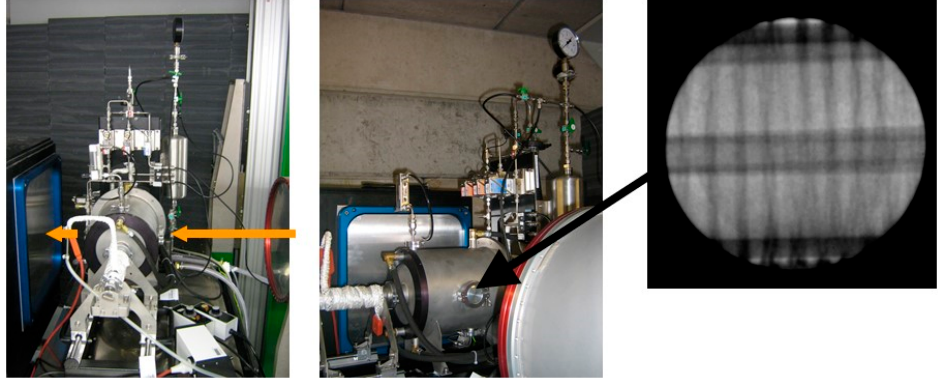
Figure 4. The INRRO furnace mounted at the ICON beamline and a radiograph of the empty furnace.